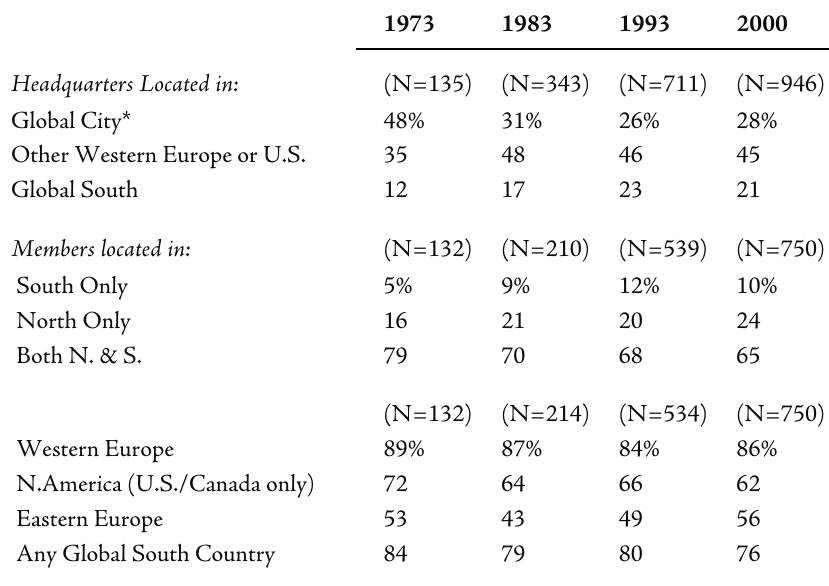
Table 4: North-South Comparisons of TSMO